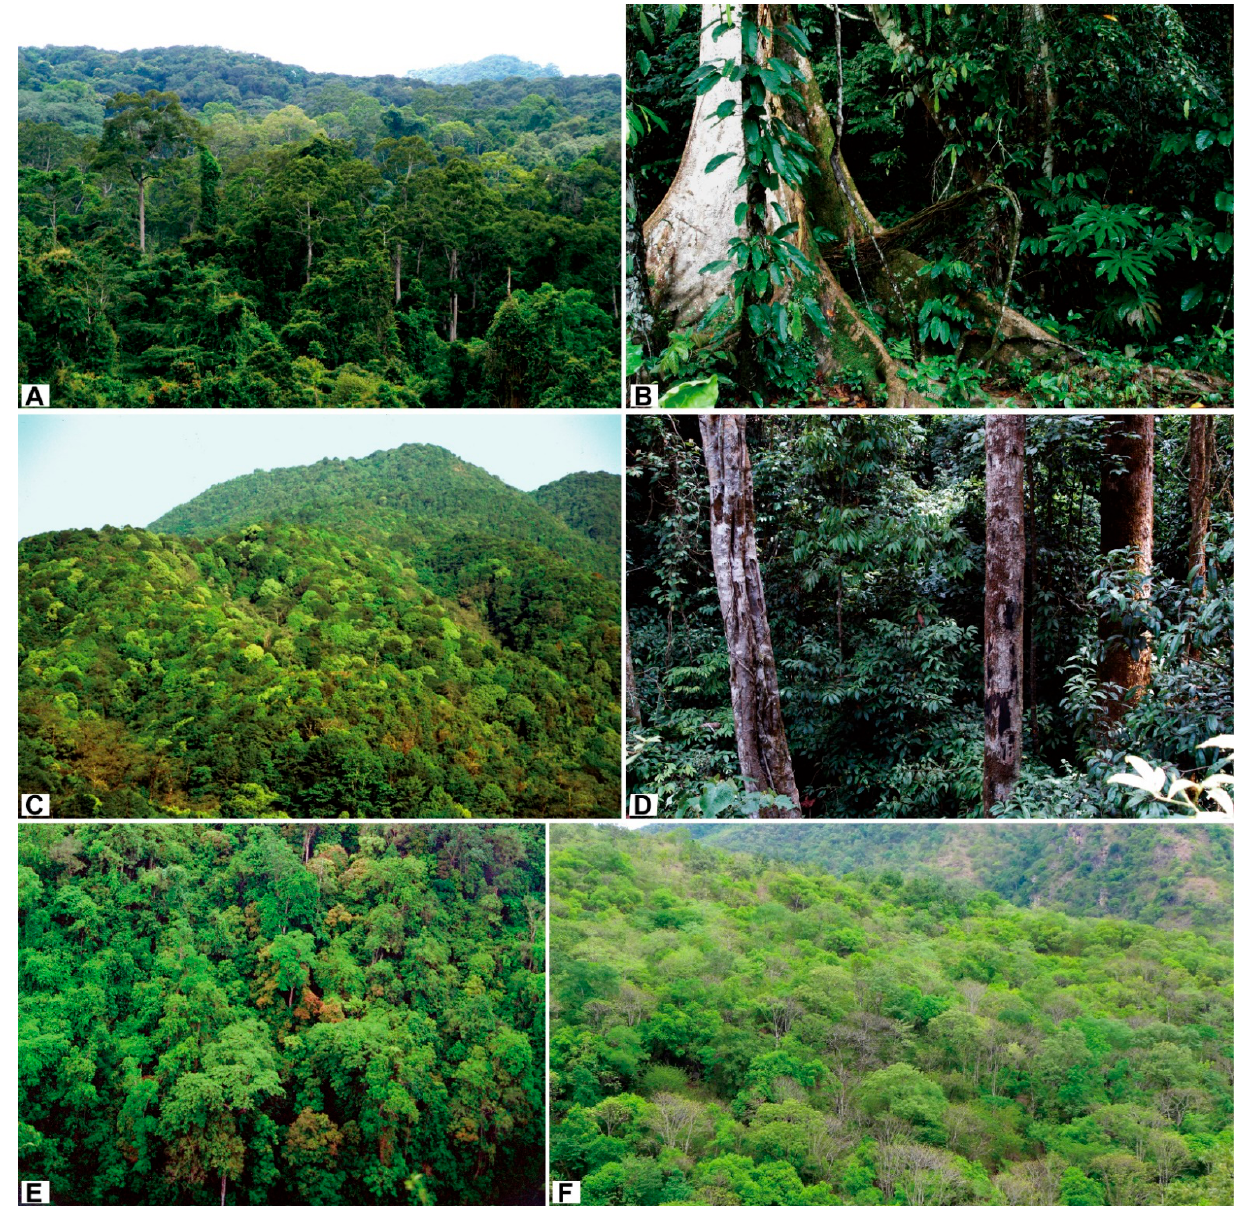
Figure 2. Topography of Yunnan with photo sites taken for vegetation types (this figure was made by the Landscape Ecology Lab., Xishuangbanna Tropical Botanical Garden, CAS; F3, F4, F5, F6 in the map are the shortening of legends in Figures 3–6).